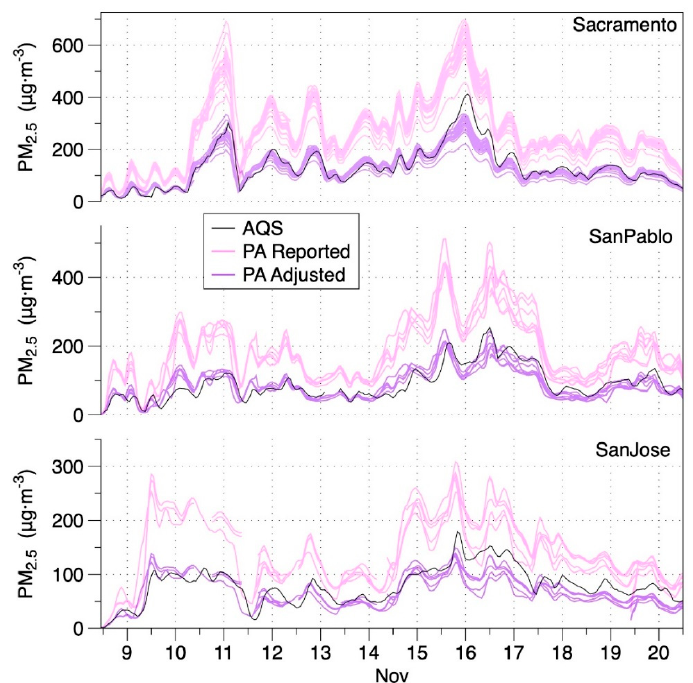
Figure 6. PM 2.5 concentrations reported by regulatory air quality monitoring stations (AQS) and all valid sensors of PurpleAir PA-II monitors nearby to three AQS sites during the Camp Fire in Northern California in November 2018. Pink data are unadjusted and purple data are adjusted using the regional event specific adjustment factor of 0.485.